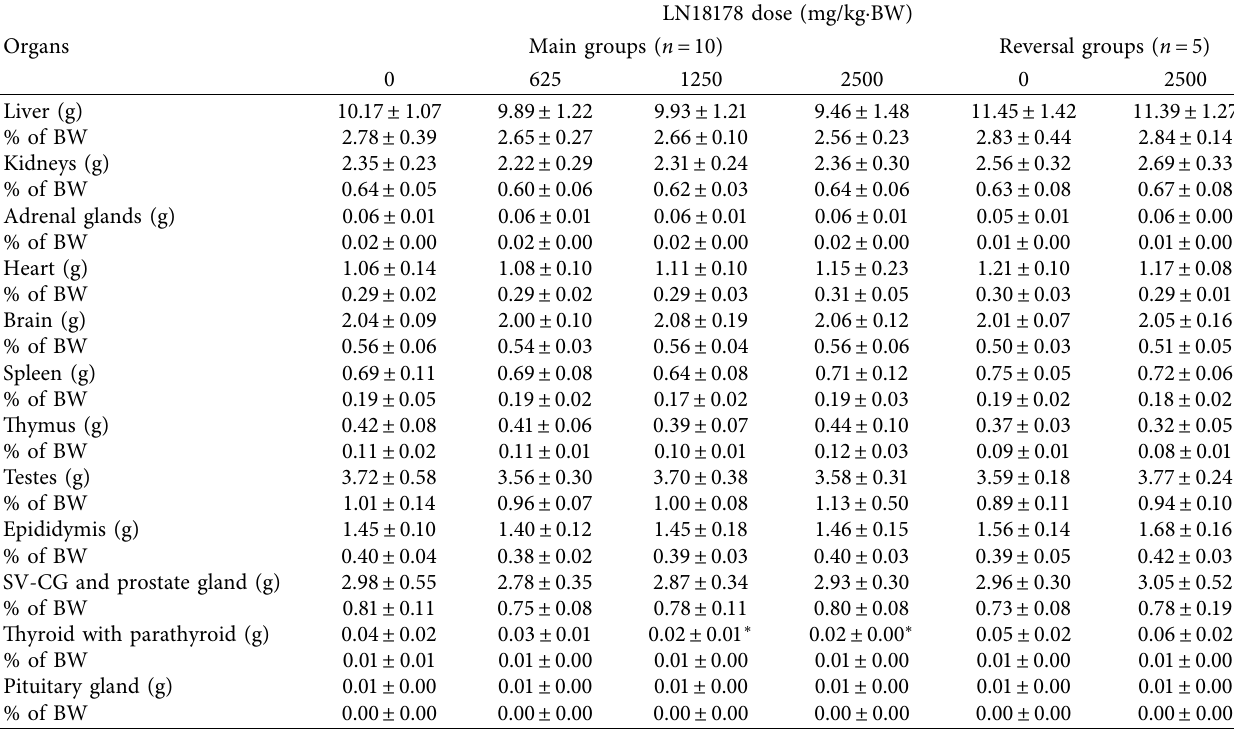
Table 5: Effect of 90-day oral administration of LN18178 on the absolute and relative organ weights of male Wistar rats. Organs